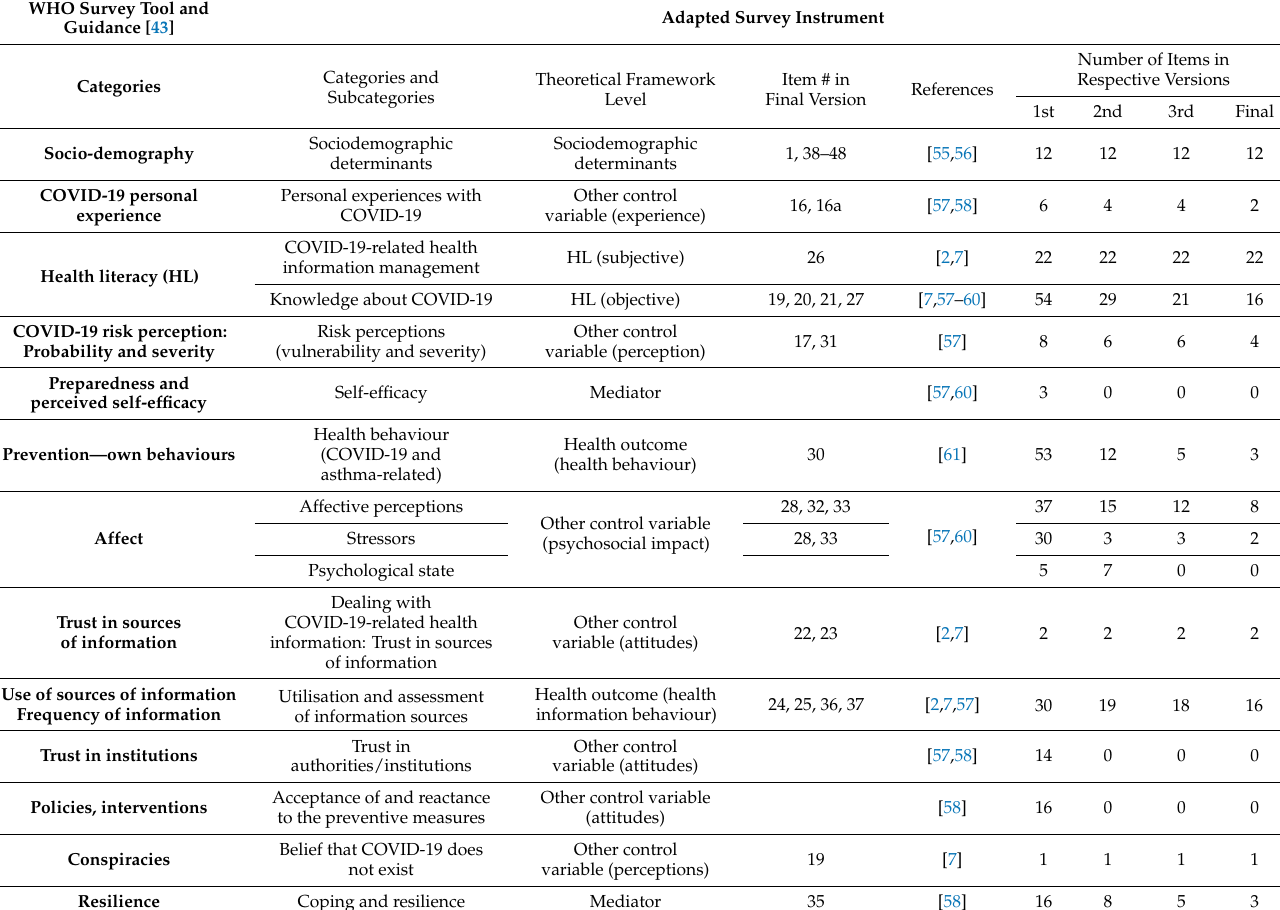
Table 1. Content of the asthma-specific survey